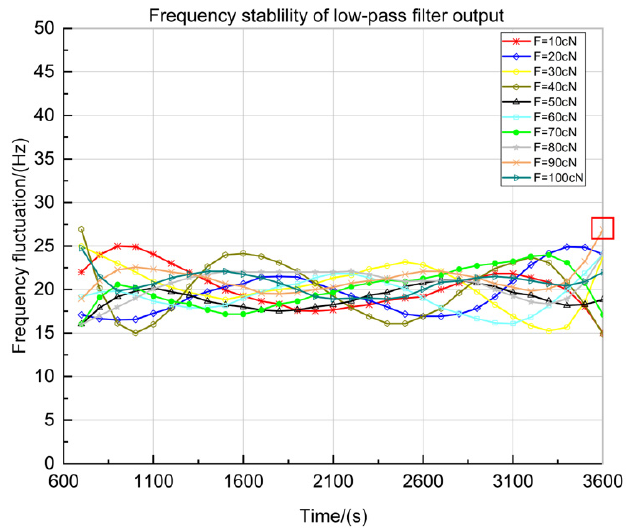
Figure 12. Frequency stability curve of low-pass filter output loaded with tension (the red box is the maximum data for all the tests) .